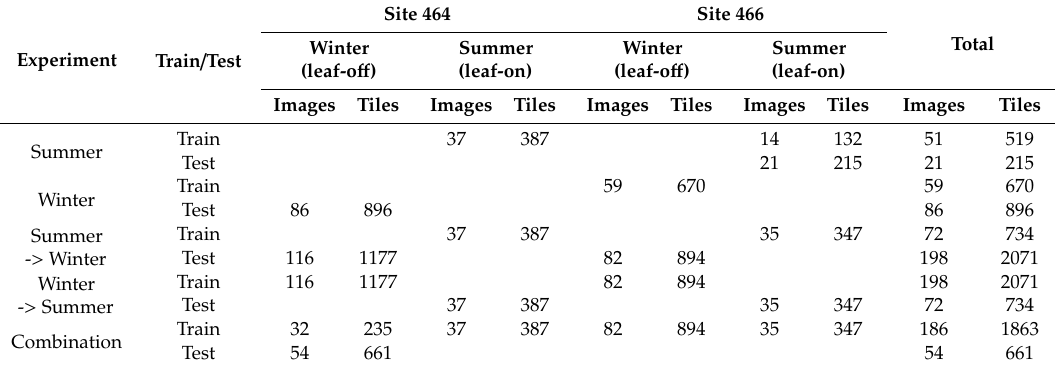
Table 1. Overview of the di ff erent training- and test sets, where all images include at least one